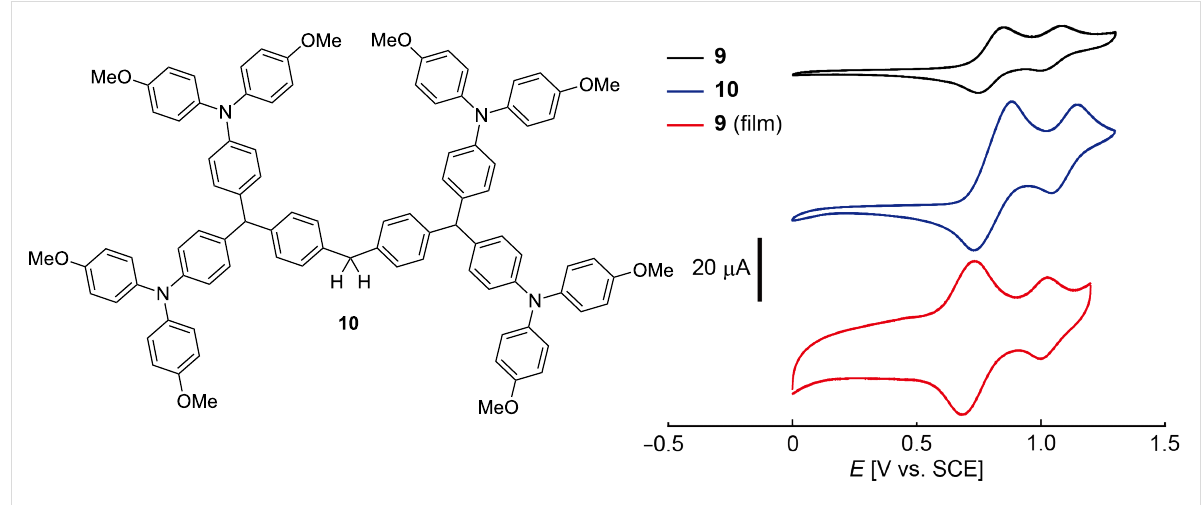
Figure 5: Cyclic voltammograms of dendronized polystyrene 9 (black line), model compound 10 (blue line), and the film of dendronized polystyrene 9 (red line). See the Experimental section for the details.